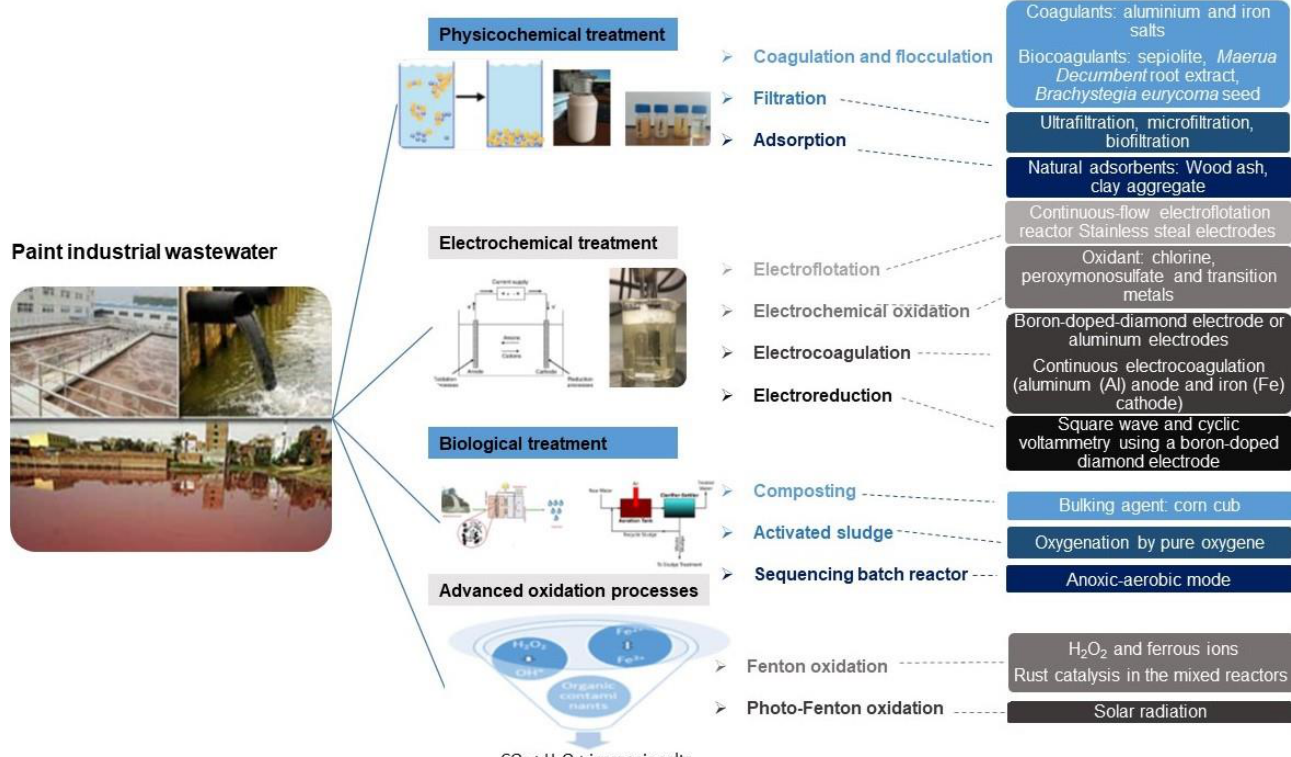
Figure 3. Distribution of industrial wastewater treatment methods according to treatment mecha- nism.